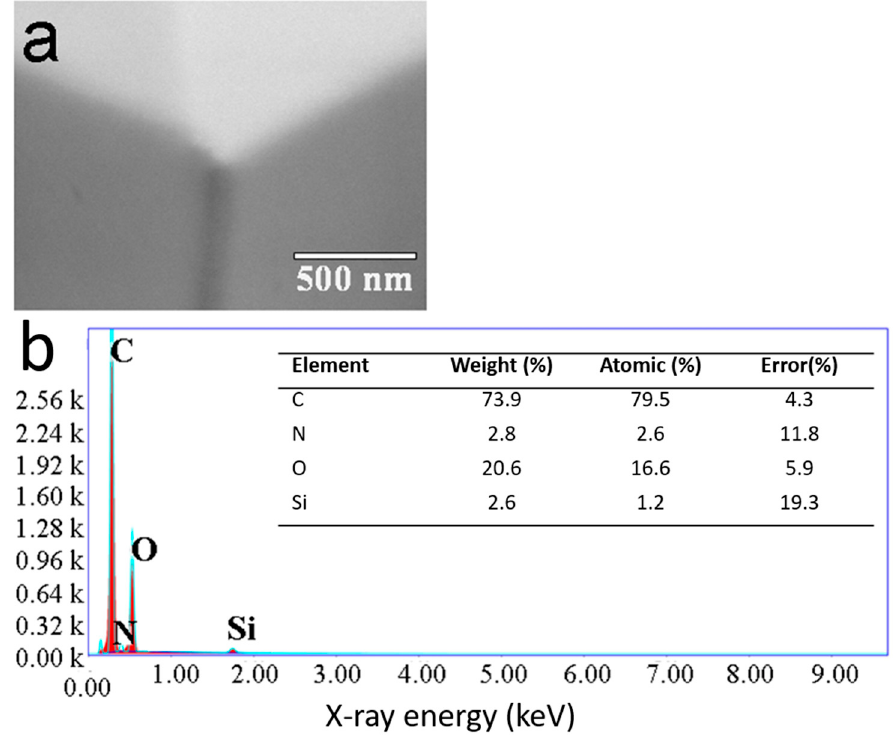
Figure 2. ( a ) SEM image of the AFM tip apex after the PBS functionalization procedure. ( b ) EDXS spectrum of the selected region and the subsequent elemental analysis. spectrum of the selected region and the subsequent elemental